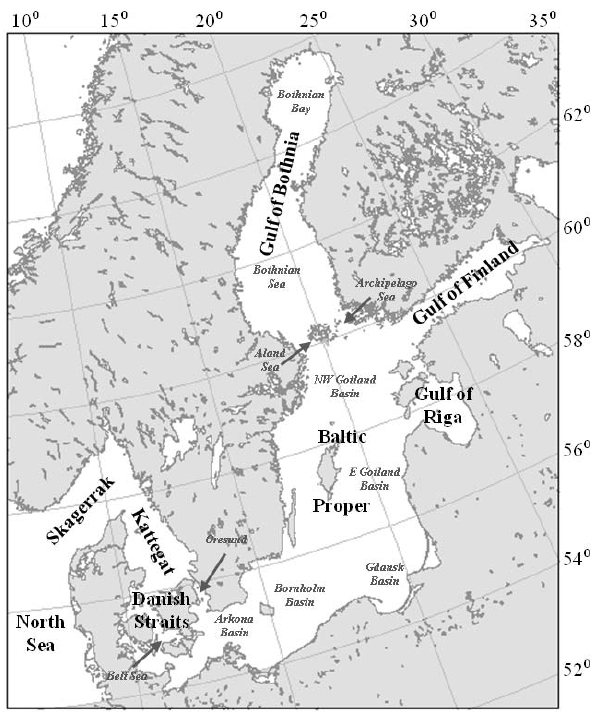
Fig. 1. Map of the Baltic Sea showing its division into natural basins and sub-basins (modified after Omstedt et al.,